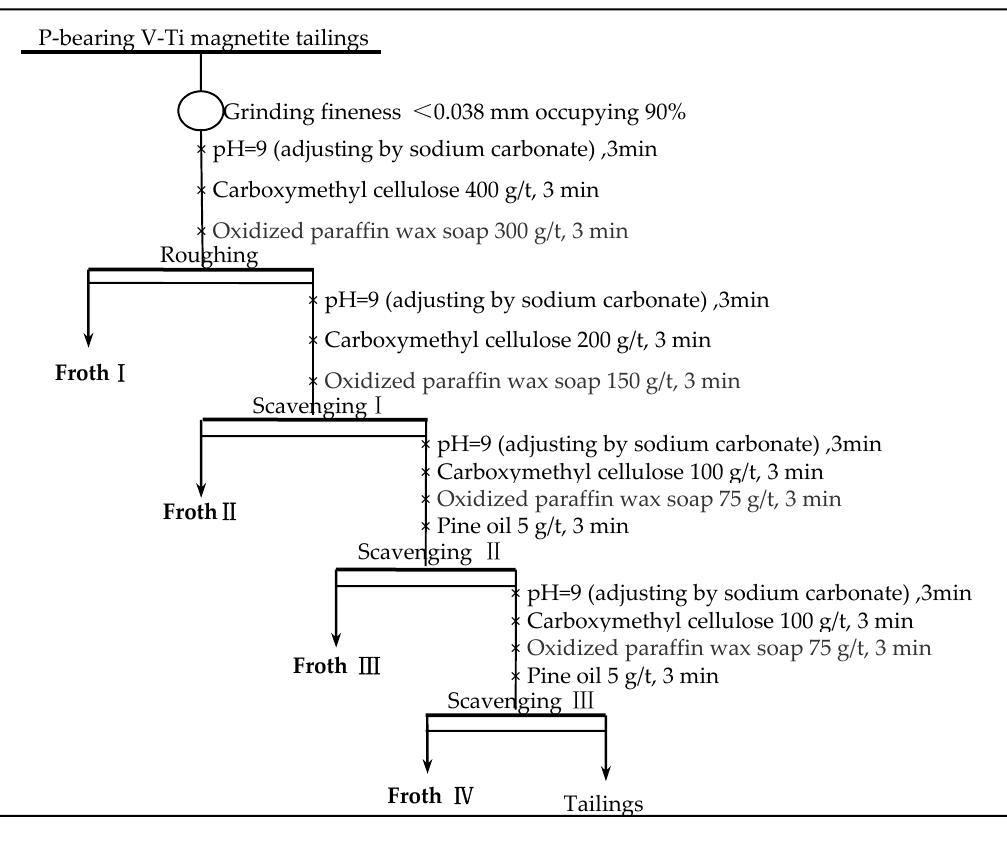
Figure 10. Time on flotation scavenging flowsheet. Table 3. E ff ect of scavenging time on P 2 O 5 grade and recovery in flotation